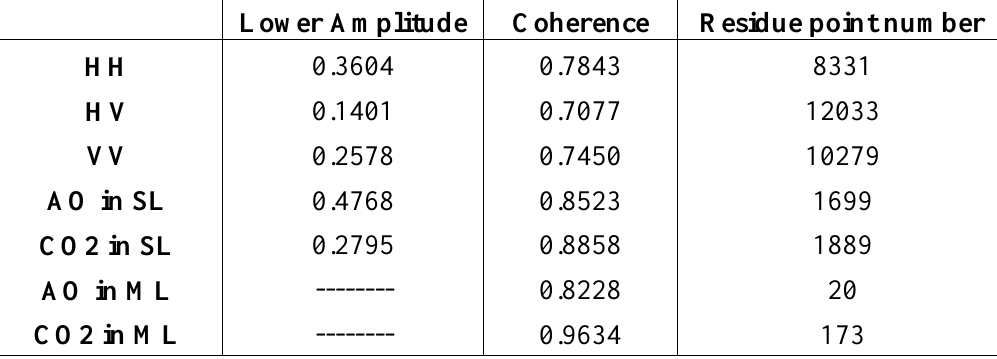
Table 1. The comparisons of average lower amplitude, average coherence and residue point number among the original HH/HV/VV channel data and the fused data processed by the AO and CO2 method in both the single-look and multi-look cases in Figure